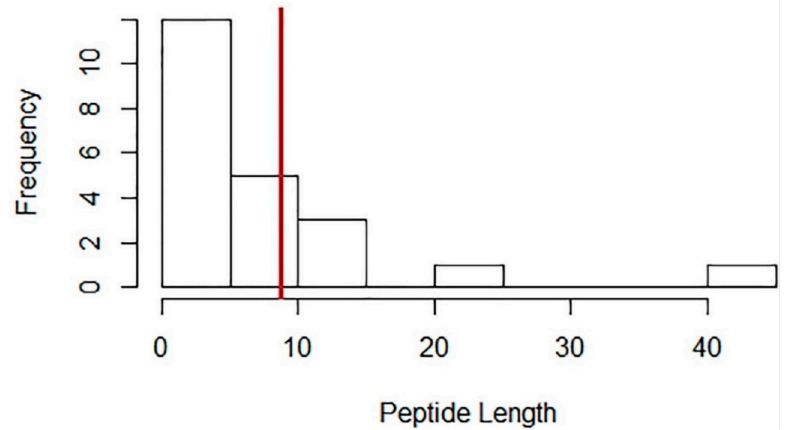
Figure 2. Histogram of the frequency of the lengths of various peptides ( n = 22) discussed in this manuscript. The mean number of amino acid residues is indicated as a brown-colored line on the x -axis.